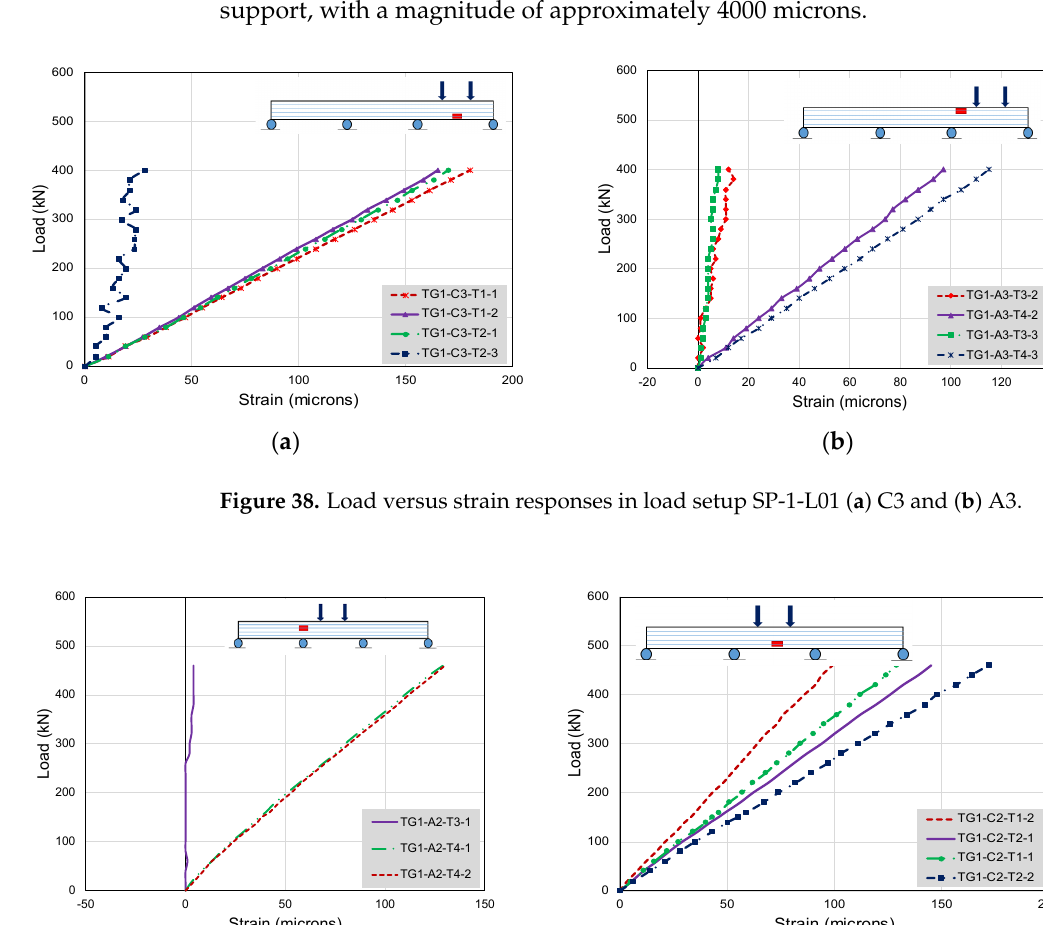
Figure 39. Load versus strain responses in load setup SP-1-L02 ( a ) A2 and ( b ) C2.